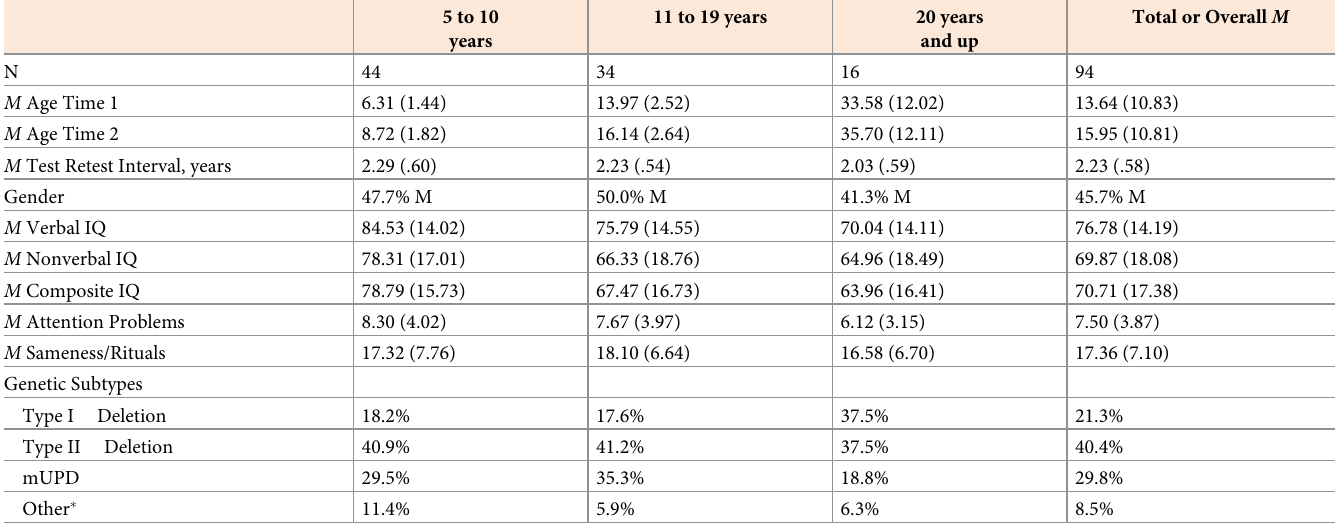
Table 1. Participant demographics and behavioral characteristics across age